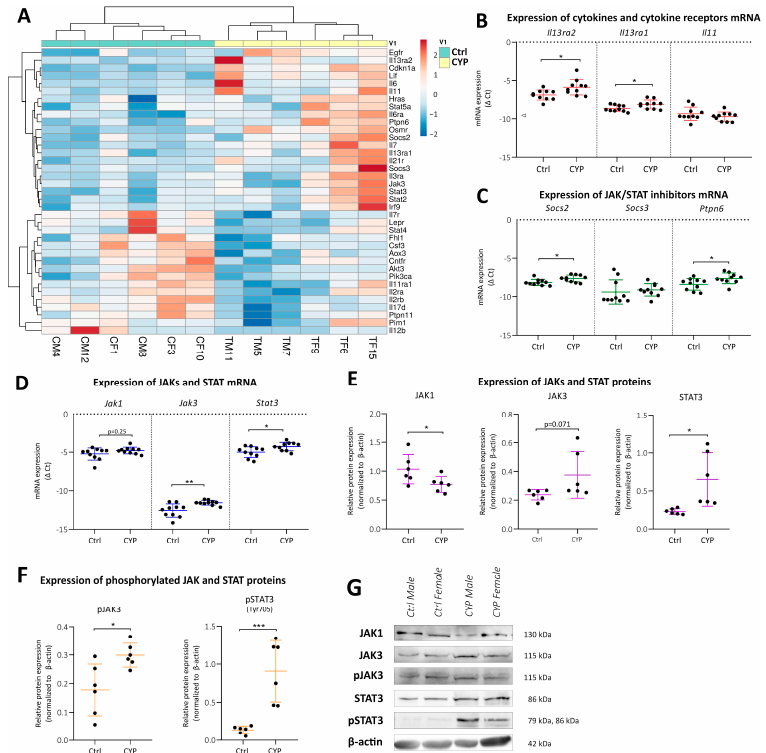
Figure 4. The JAK/STAT signaling pathway is activated in the bladders of CYP-treated animals. ( A ) Heatmap showing DEGs ( n = 37) with p adj < 0.05 detected in the JAK/STAT signaling pathway by KEGG analysis comparing the CYP (yellow; n = 6 animals) vs. Ctrl (green; n = 6 animals) groups. Both the rows and columns are clustered using correlation distance and average linkage. Lower expression is marked in blue, and higher expression is marked in red. CM: Ctrl male; CF: Ctrl female; TM: CYP-treated male; TF: CYP-treated female. ( B ) qPCR validation of mRNA expression for cytokines and cytokine receptors ( Il13ra2 , Il13ra1 , Il11 ), comparing CYP and Ctrl animals. Shown are the mean ± SD of negative ∆ Ct determined for 10 animals per group. The qPCR analysis was not reliable for some DEGs identified as cytokines and cytokine receptors in the JAK/STAT signaling pathway ( Il6 , Il6ra , Il7 , Il21r , Il3ra ), therefore the results are not presented. ( C ) qPCR validation of mRNA expression for inhibitors of JAK/STAT signaling ( Socs2 , Socs3 , Ptpn6 ), comparing CYP and Ctrl animals. Shown are the means ± SD of negative ∆ Ct determined for 10 animals per group. ( D ) qPCR validation of transcript expression for the analyzed JAK and STAT molecules ( Jak1 , Jak3 , Stat3 ), comparing CYP and Ctrl animals. Shown are the means ± SD of negative ∆ Ct determined for 10 animals per group. ( E ) Expression of JAK and STAT proteins (JAK1, JAK3, and STAT3), determined by Western blot in Ctrl and CYP animals. Shown are the mean ± SD of relative protein expression normalized to β -actin for six animals per group. ( F ) The expression of phosphorylated JAK and STAT proteins (pJAK3, pSTAT3), determined by Western blot in Ctrl and CYP animals. Shown are the mean ± SD of relative protein expression normalized to β -actin for six animals per group. ( G ) Representative blots for the analysis of protein expression in six animals per group. * p < 0.05; *** p <